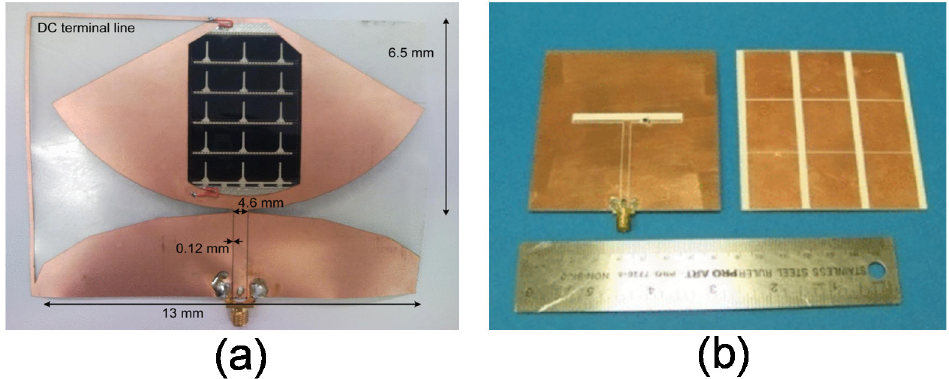
Figure 22. ( a ) Hybrid solar and electromagnetic energy (EM) energy harvesting antenna on PET substrate [263] and ( b ) reconfigurable antenna with AMC surface [271].